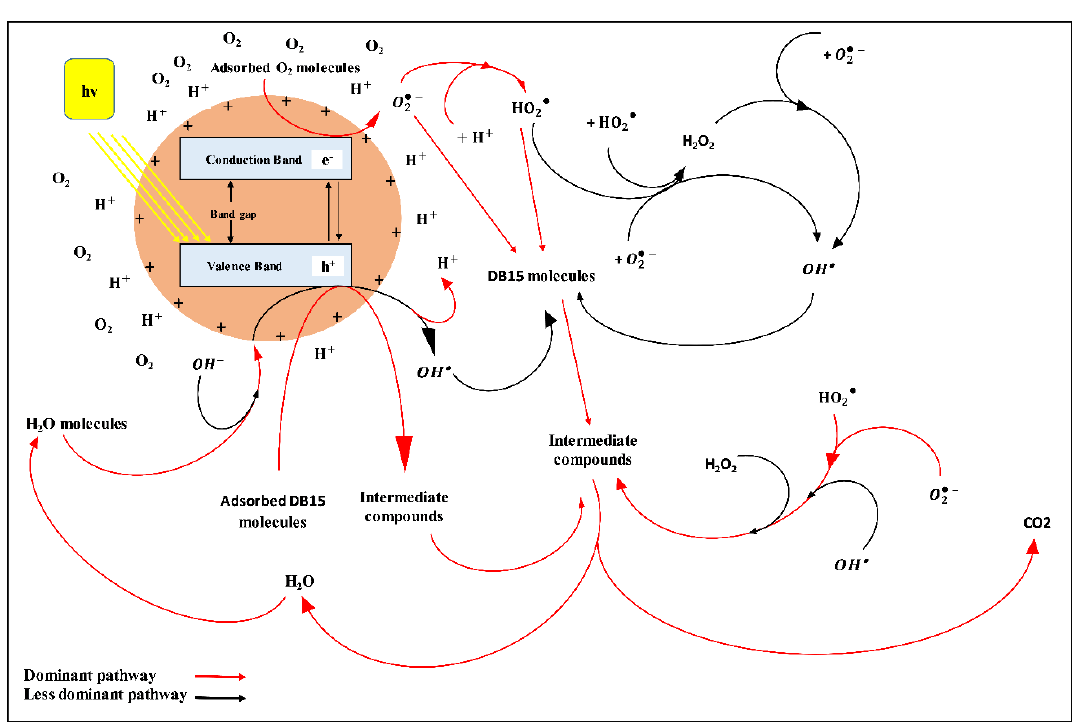
Figure 20. General mechanism of DB15 degradation at low pH